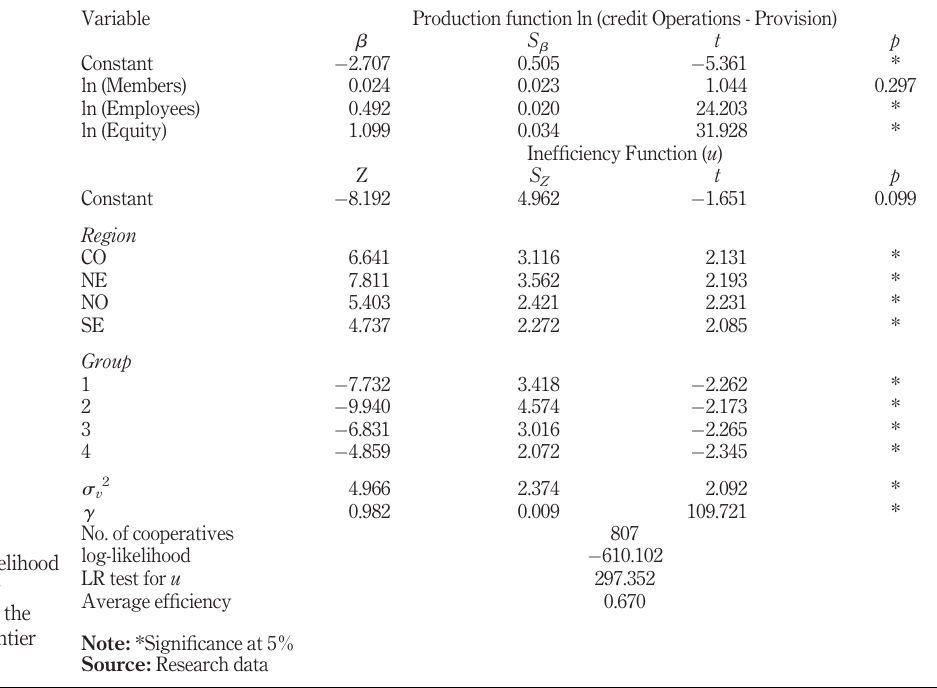
Table 2. Maximum likelihood estimation for coef fi cients of the stochastic